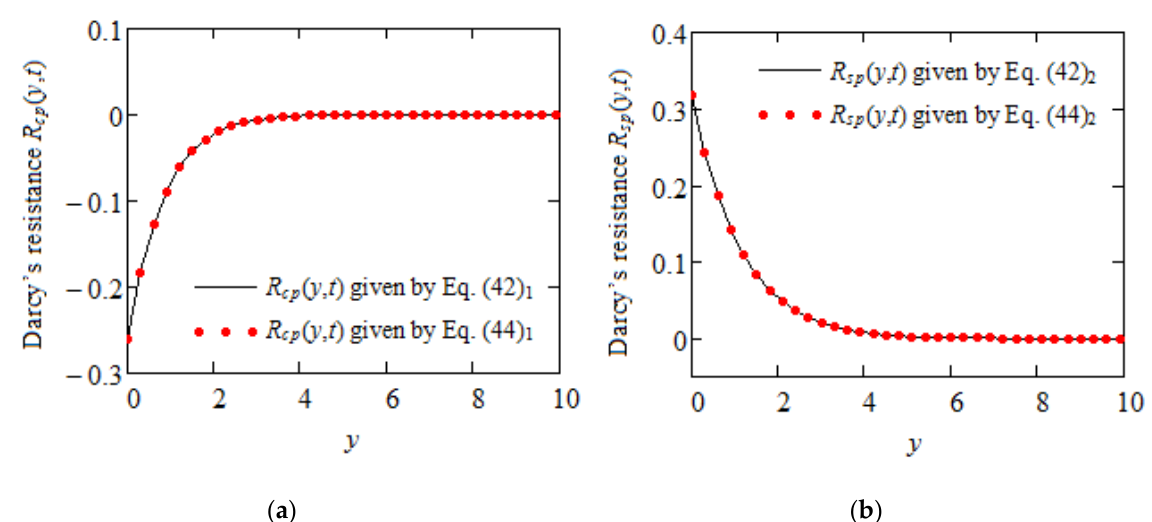
Figure 4. Equivalence of Darcy’s resistances R cp ( y , t ) and R sp ( y , t ) given by Equations (42) and (44), for α = 0.8, ω = π /12, M = 0.6, K = 0.4, and t =